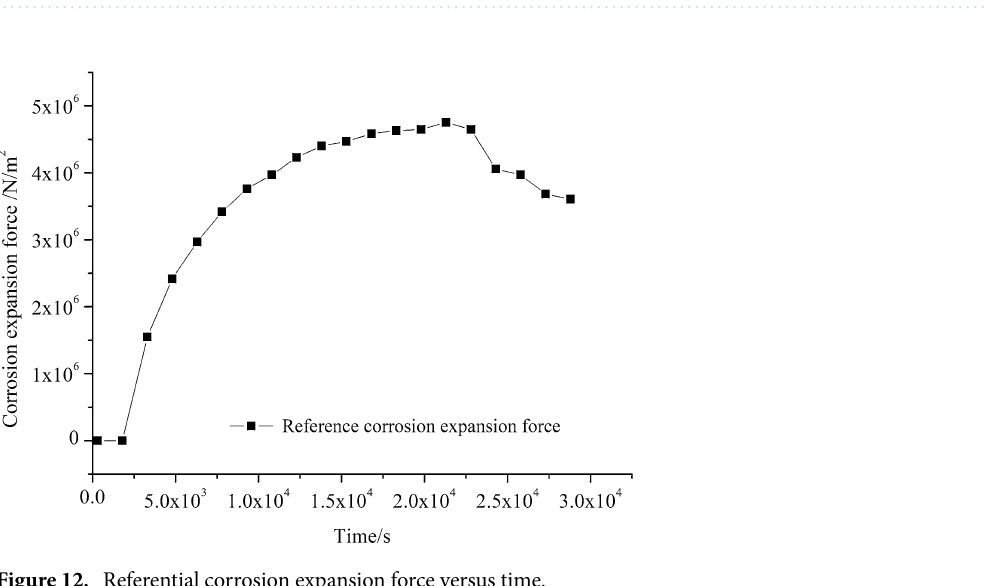
Figure 11. Change of corrosion rate of reinforcement with time.